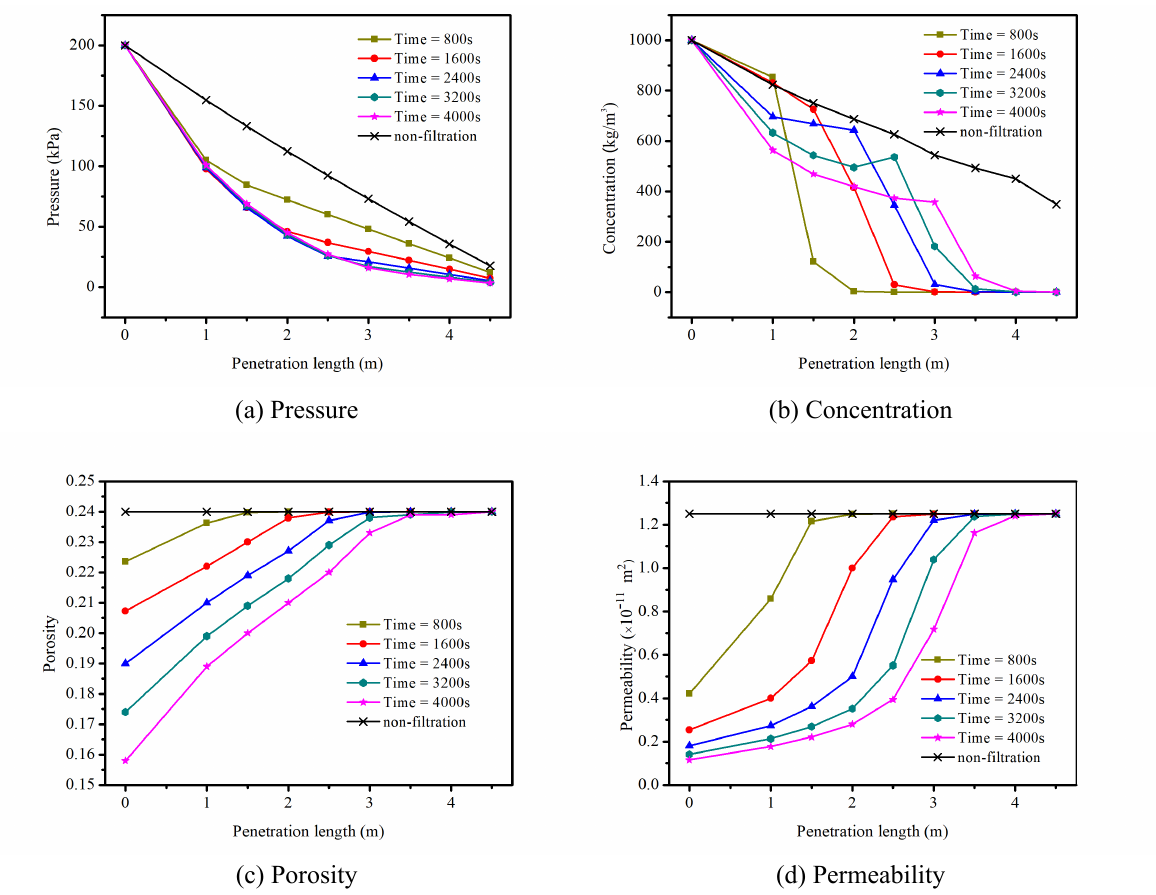
Figure 5. Variations in the pore pressure, concentration, porosity and permeability with the penetration